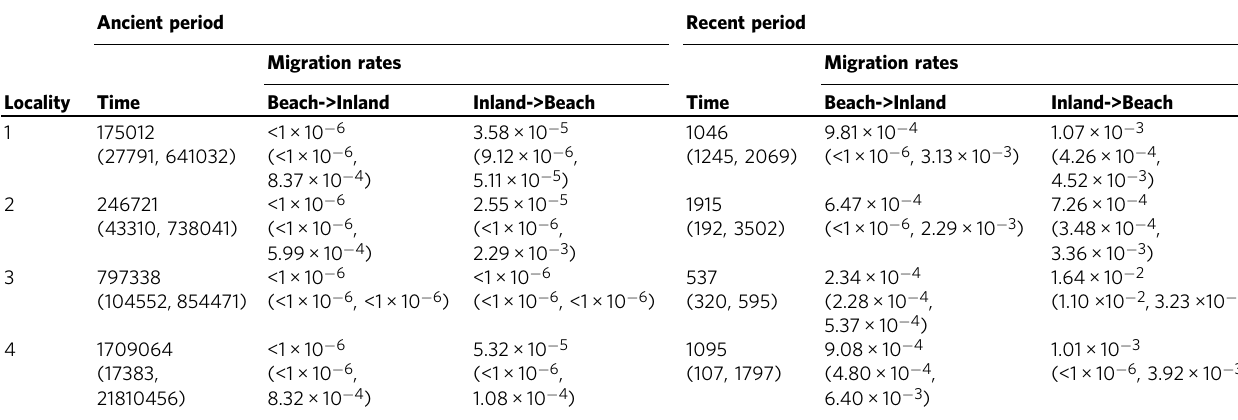
Fastsimcoal2parameterestimates andcorresponding bootstrapvalues forthe modelallowingtwo periods ofgene fl ow forthe ALLSNPdataset. Underthe favouredmodel(seeTable 1),earlydivergence was proceeded by lower beach-inland migration rates (i.e., during the “ Ancient period ” ). This was followed by a “ Recent period ” of relatively higher migration rates. Each of these periods was estimated to have begun at a speci fi c Time (estimates in generations before present) while Beach->Inland and Inland->Beach migration rates represent the estimated probabilities of a lineage within one of these habitatsmoving tothe otherhabitat,pergeneration, goingforwardsin time.The 95%bootstrap con fi dence intervalsforallestimates aregiveninparentheses. Samplesizesfor localities1 – 4 were:17, 17, 20, and 17,